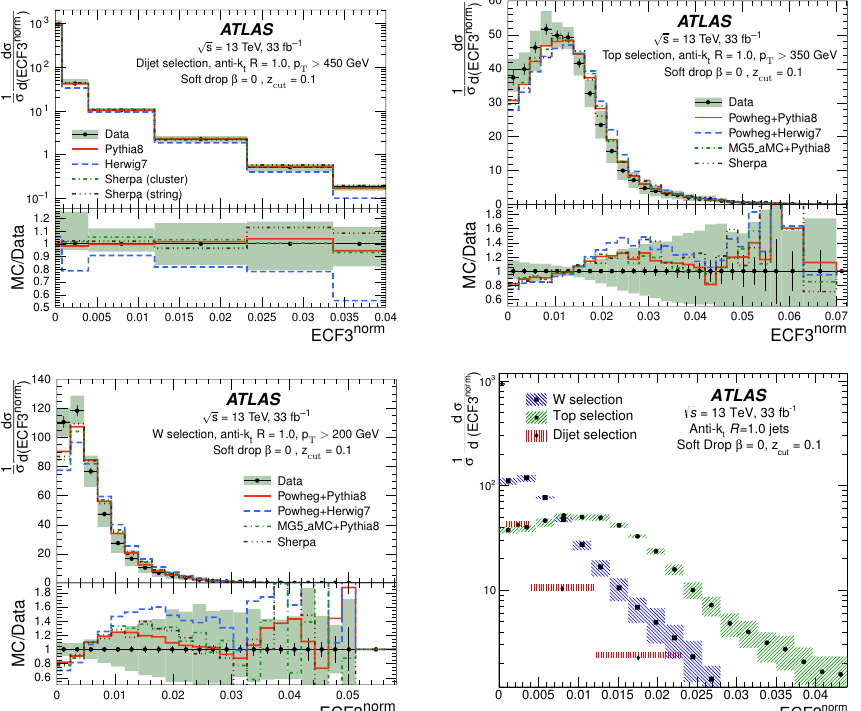
Figure 8 . The distributions of ECF 3 Norm are compared with different MC predictions for soft- dropped large-radius jets from dijet (top left), top (top right), and W (bottom left) selections. For the dijet selection, Sherpa is tested with two different hadronisation models. Data are compared between the soft-dropped large-radius jets for the three selections mentioned above (bottom right The superscript “norm” indicates that normalised versions of ECF 3 Norm are used. The shaded bands represent the total uncertainty, while the error bars show the statistical uncertainty, except in the bottom right plot, where the shaded areas represent the total